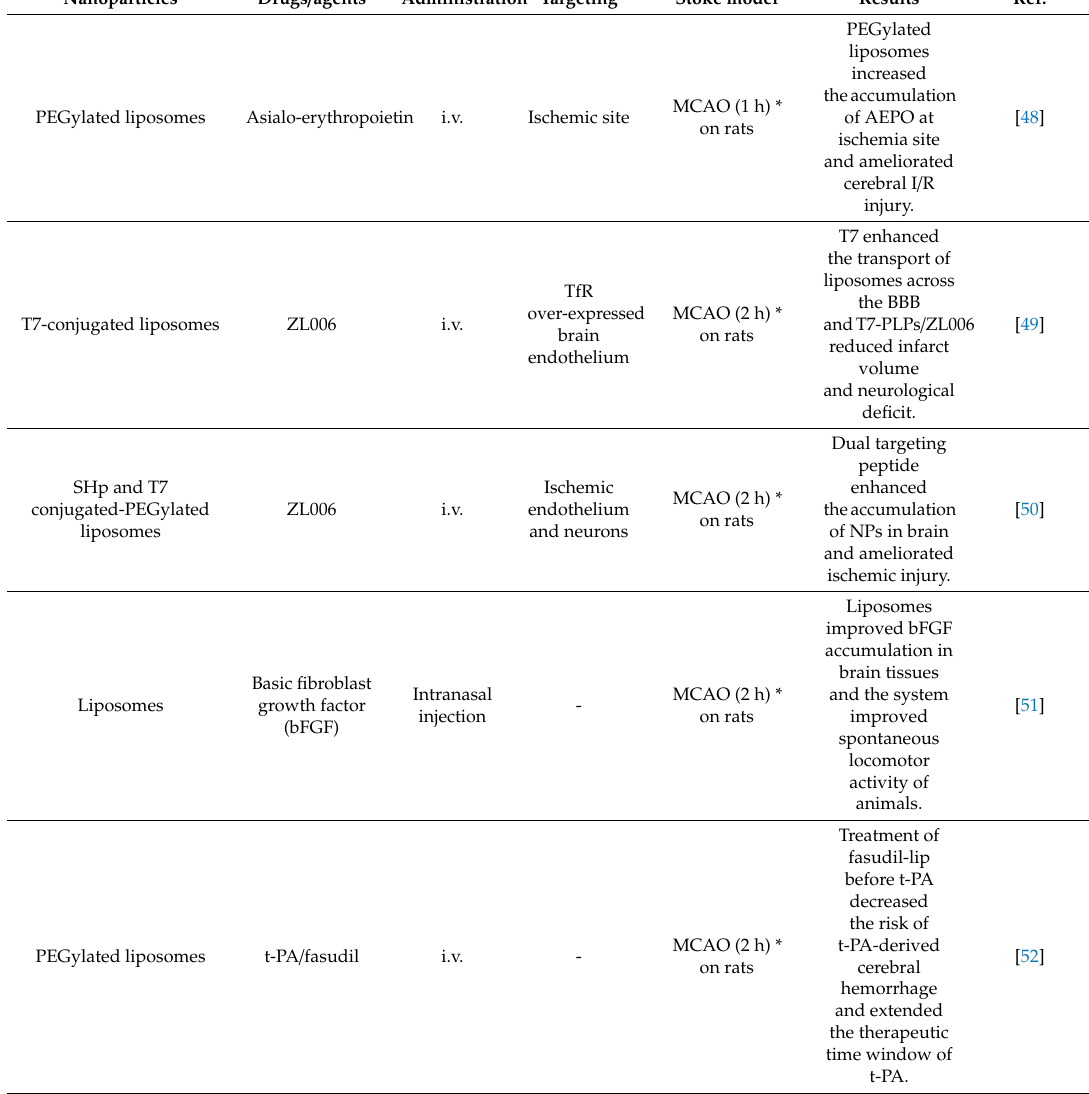
Table 1. Studies of nanoparticle-based drug delivery in ischemic